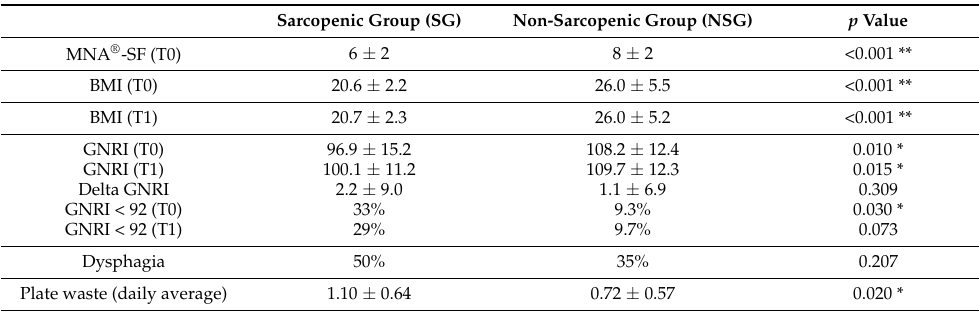
Table 2. Nutritional status variables in Sarcopenic Group (SG) and Non-Sarcopenic group (NSG). Data are reported as mean ± standard deviation or number percentage (%). p values refer to the Mann–Whitney U test or the χ 2 test, as appropriate.